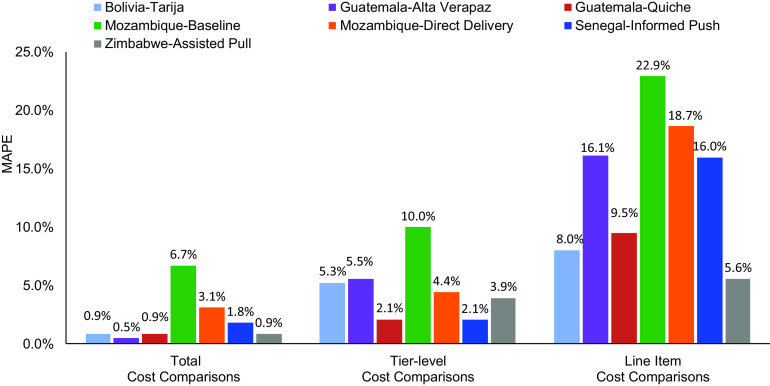
Comparison of Cost Estimates Between the Rapid Supply Chain Modeling Tool and Existing Reference Supply Chain AnalysesAbbreviation: MAPE, mean absolute percent error.